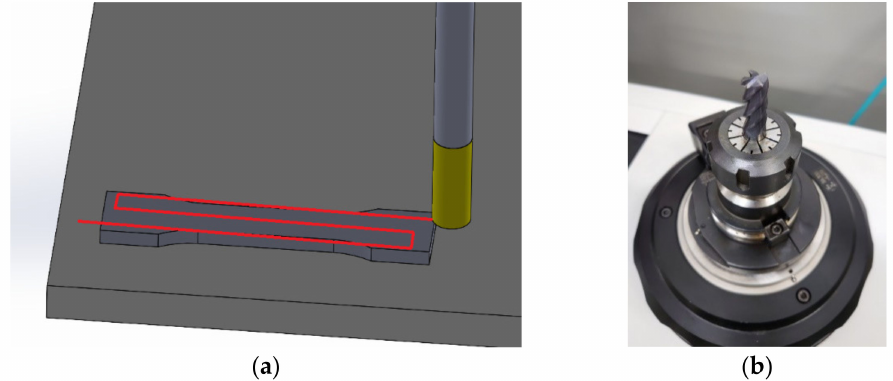
Figure 2. ( a ) Milling strategy for printed samples; ( b ) milling